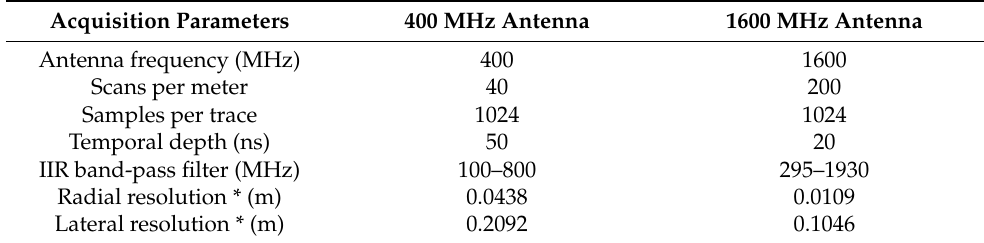
Table 1. Acquisition parameters of GPR surveys.